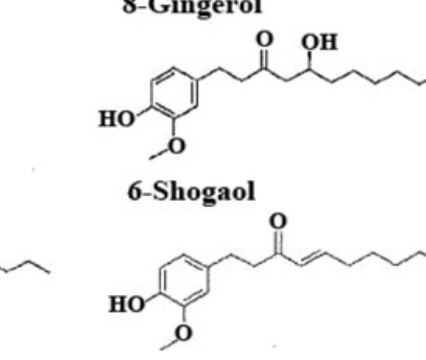
Fig. 1. Structure of 6-Gingerol, 8-Gingerol, 10-Gingerol and